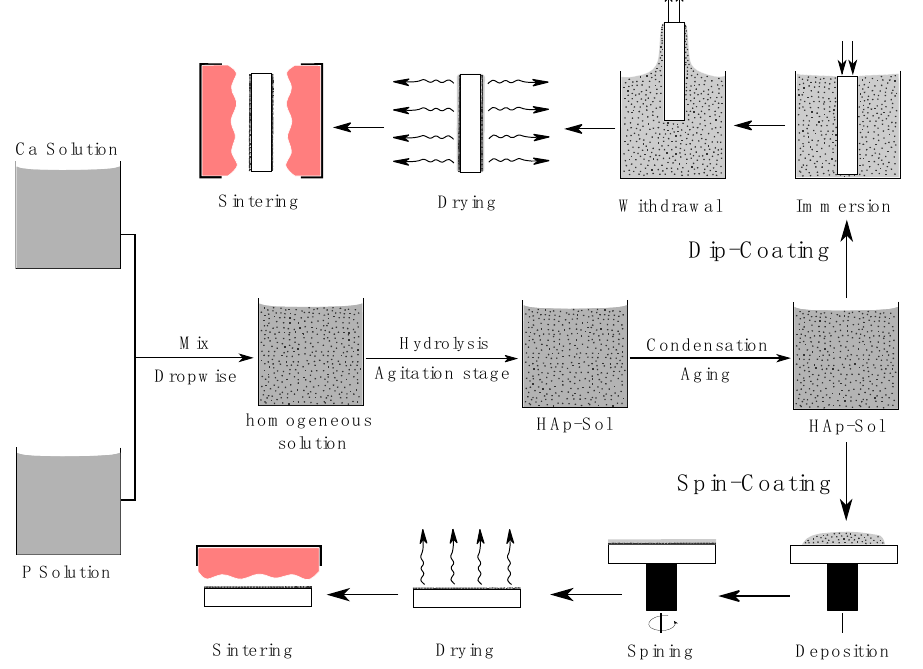
Figure 1. Fundamental stages of sol-gel HAp preparation and deposition by dip and spin coating.